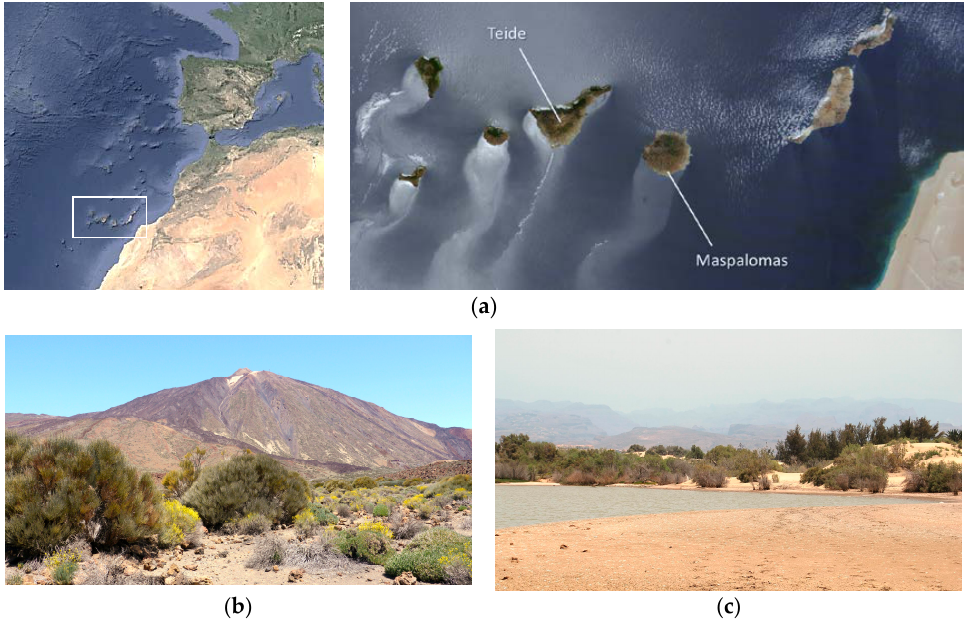
Figure 1. Natural protected areas: ( a ) Location of the Canary Islands; ( b ) Teide National Park; ( c ) Maspalomas Special Natural Reserve.